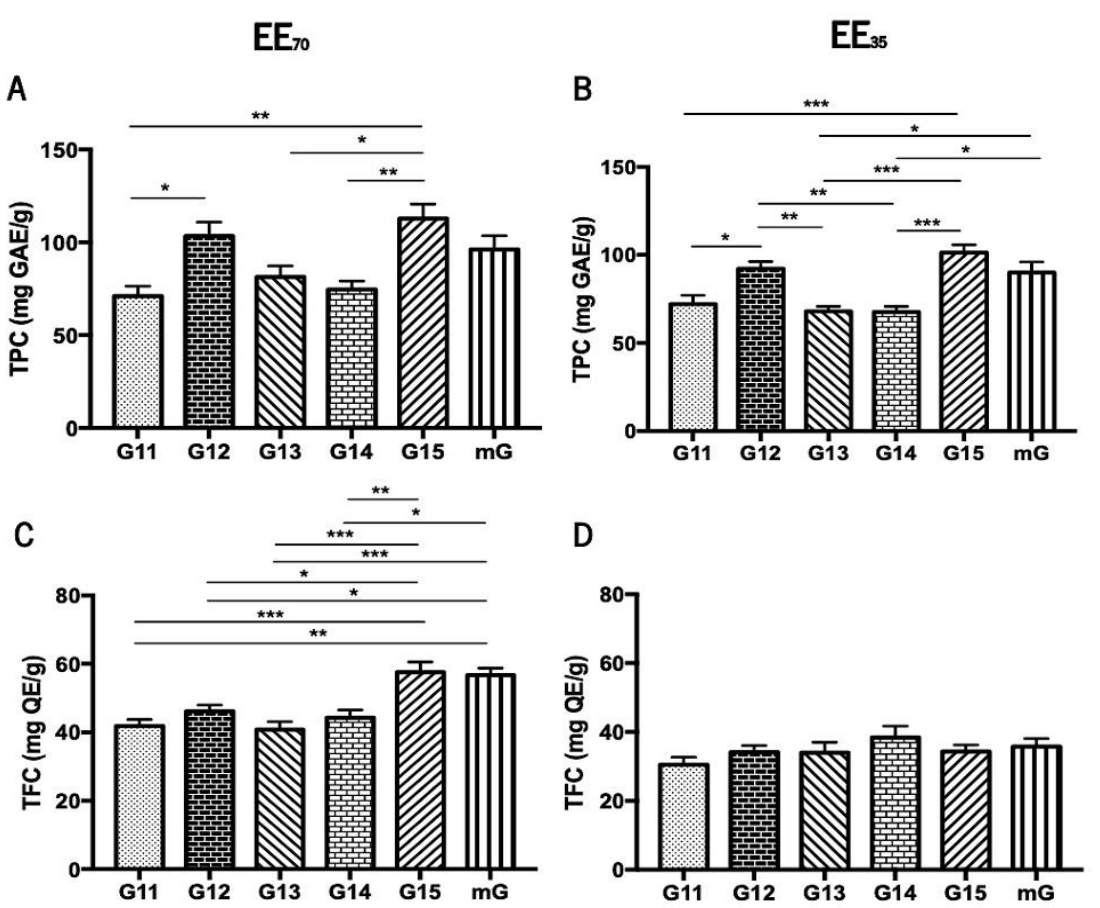
Figure 2. Total phenolic content (TPC) and total flavonoid content (TFC) of propolis from Ger ê s. TPC of G.EEs 70 ( A ) and of G.EEs 35 ( B ) measured in mg GAE/g; TFC of the G.EEs 70 ( C ) and of G.EEs 35 ( D ) measured in mg QE/g. Results are expressed as means ± SEM (* 0.05 > p ≥ 0.01, ** 0.01 > p ≥ 0.001, *** p < 0.001) (G: Ger ê s; mG: a mixture of all the propolis samples from Ger ê s harvested over 5